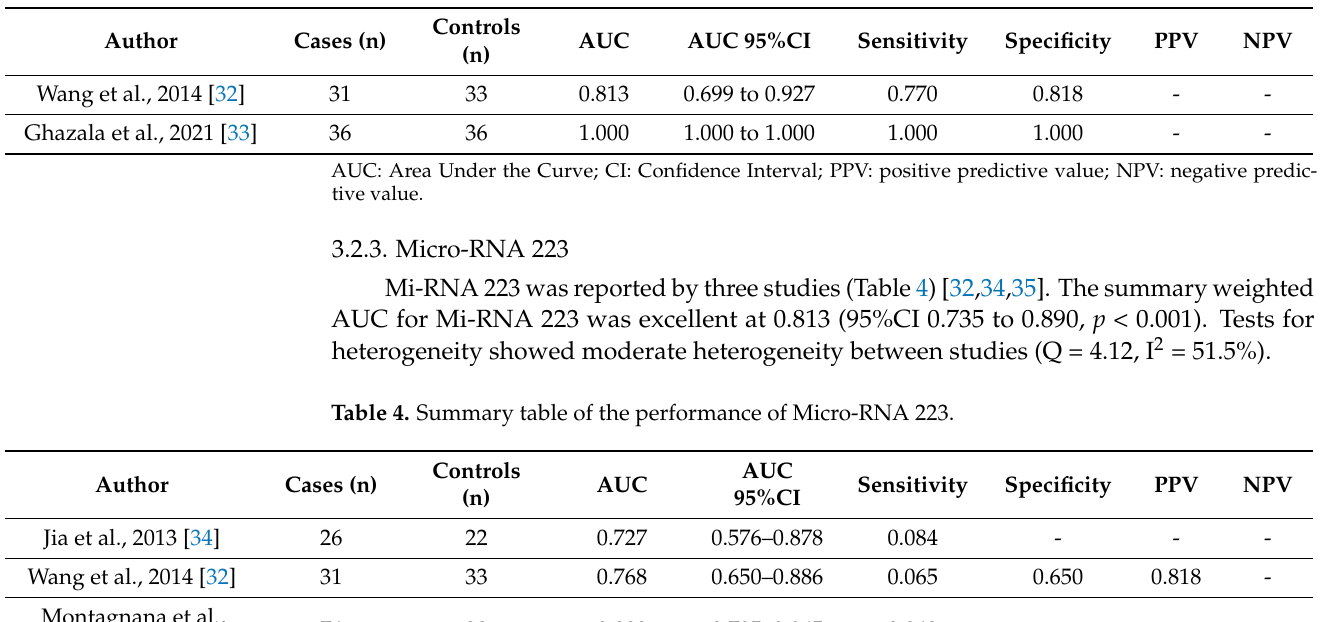
Table 3. Summary table of the performance of Micro-RNA 27a.